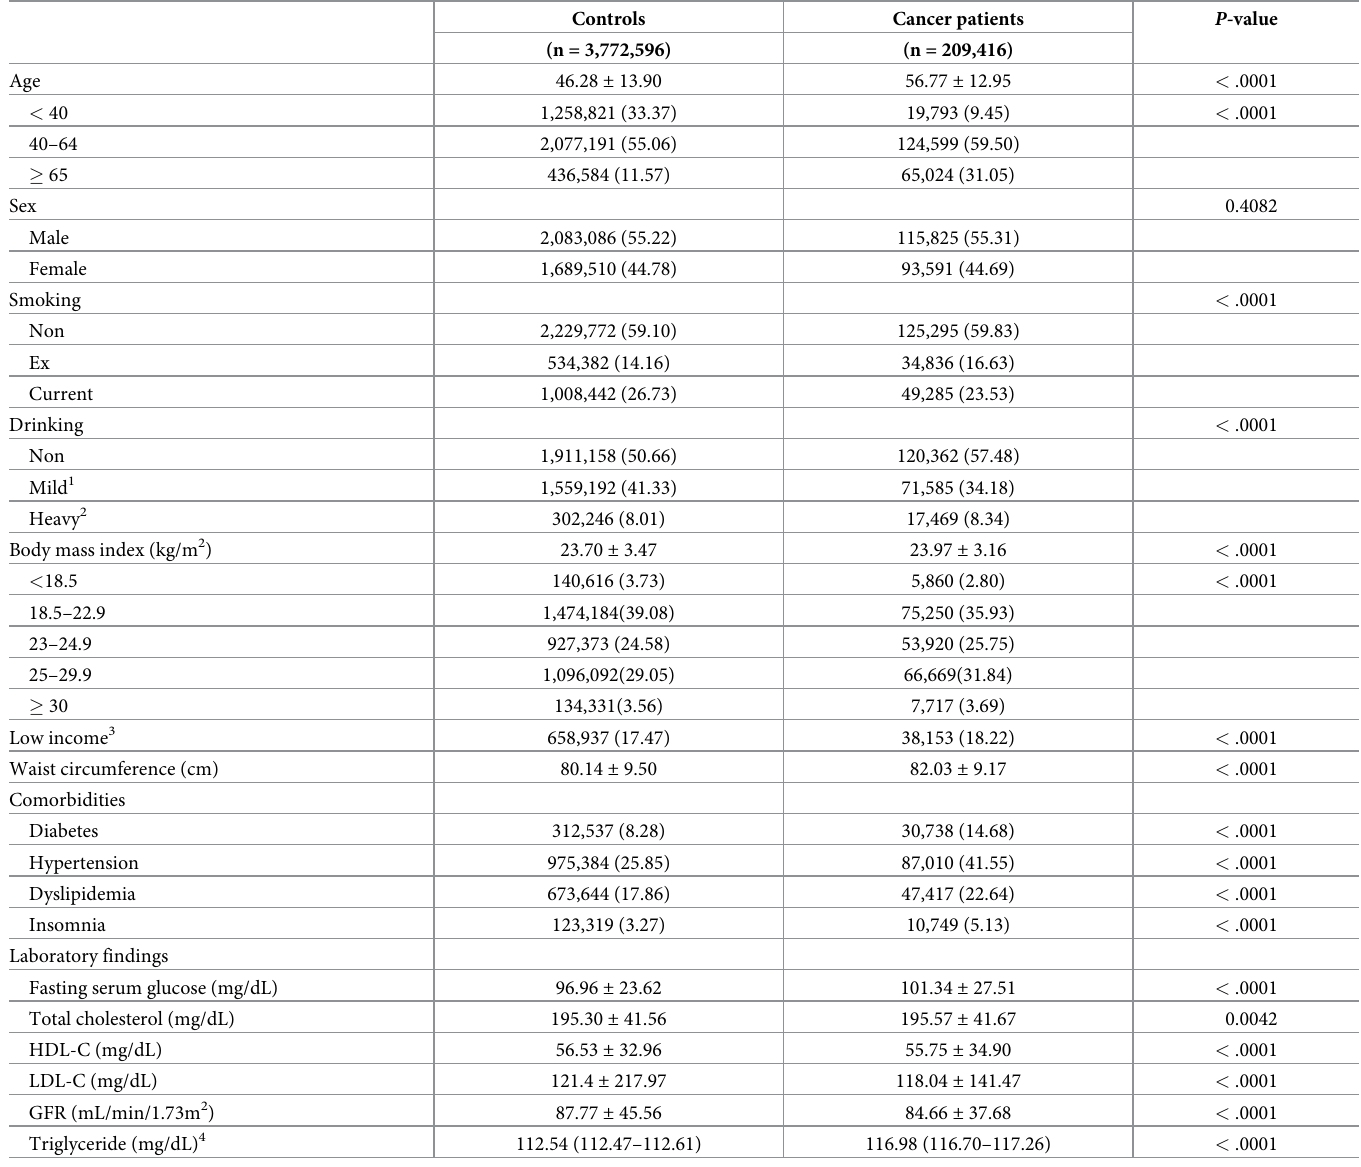
Table 1. Baseline characteristics of cancer and non-cancer subjects at